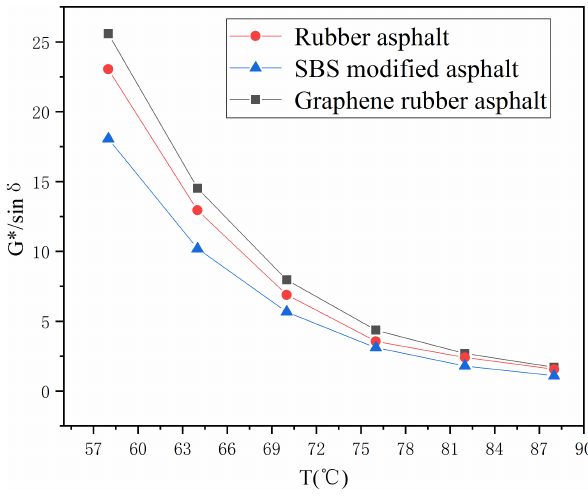
Figure 4: Relationship between G */ sin δ and T